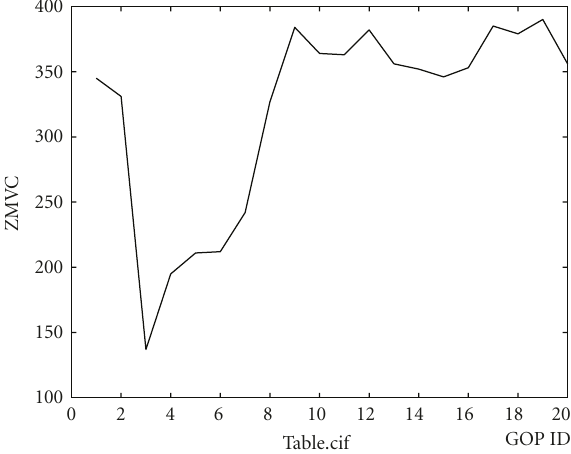
Figure 4: The ZMVC of each GOP for table sequence.